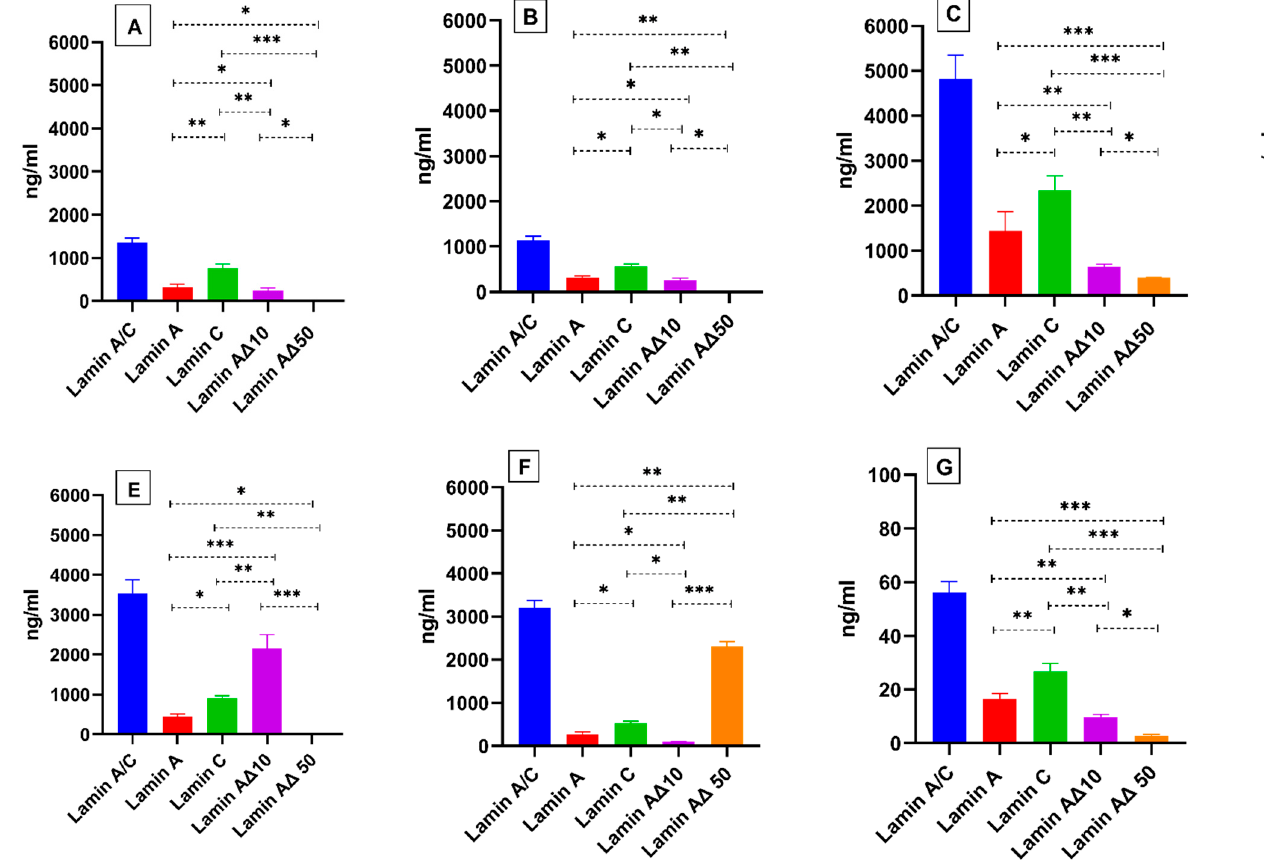
Figure 3. Protein quantitation of total lamin A / C and calculated lamin A, lamin C, lamin A ∆ 10, and lamin A ∆ 50. Di ff erential protein expression levels of lamin A / C transcript variants were measured in ( A ) the non-transfected MCF7 cell line, ( B ) the PCMV6-XL4 transfected MCF7 (Mock transfection), and following transfection of MCF7 cells with cDNA coding for ( C ) lamin A, ( D ) lamin C, ( E ) lamin A ∆ 10, and ( F ) lamin A ∆ 50. Total lamin A / C and calculated lamin A, lamin C, lamin A ∆ 10, and lamin A ∆ 50 were also measured in ( G ) the U937 cell line. Values are expressed as mean ± standard error ( n = 9). Statistical comparisons of significant di ff erences between groups with adjoining lines: * p < 0.01, ** p < 0.001, *** p < 0.0001.